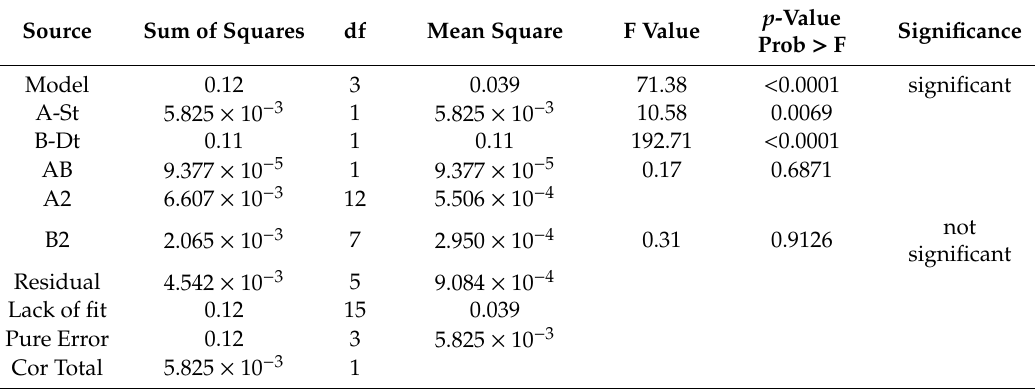
Table 8. ANOVA for microhardness.